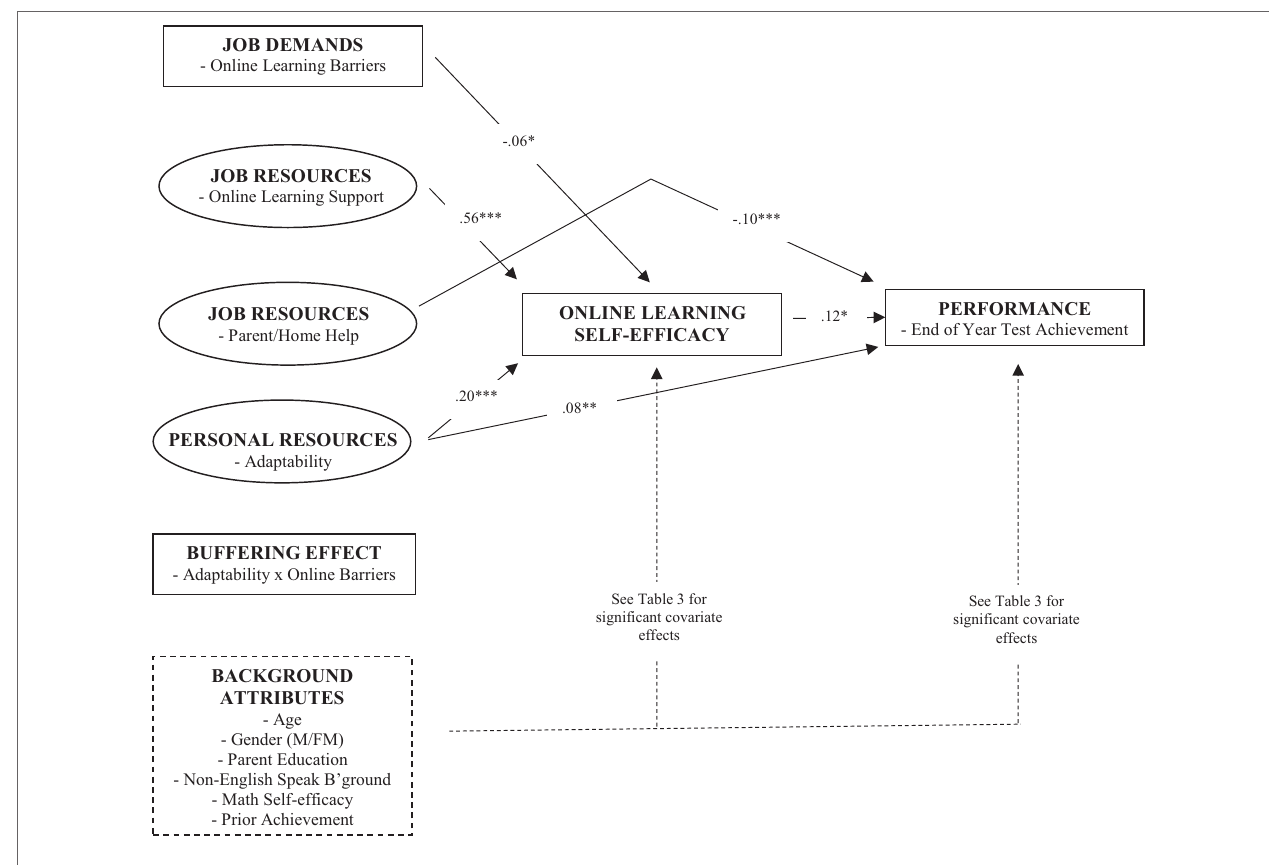
FIGURE 2 | Standardized beta coefficients for JD-R process in online mathematics. All JD-R factors are in relation to mathematics; * p < 0.05, ** p < 0.01, and *** p < 0.001. See Table 3 for indirect and covariate